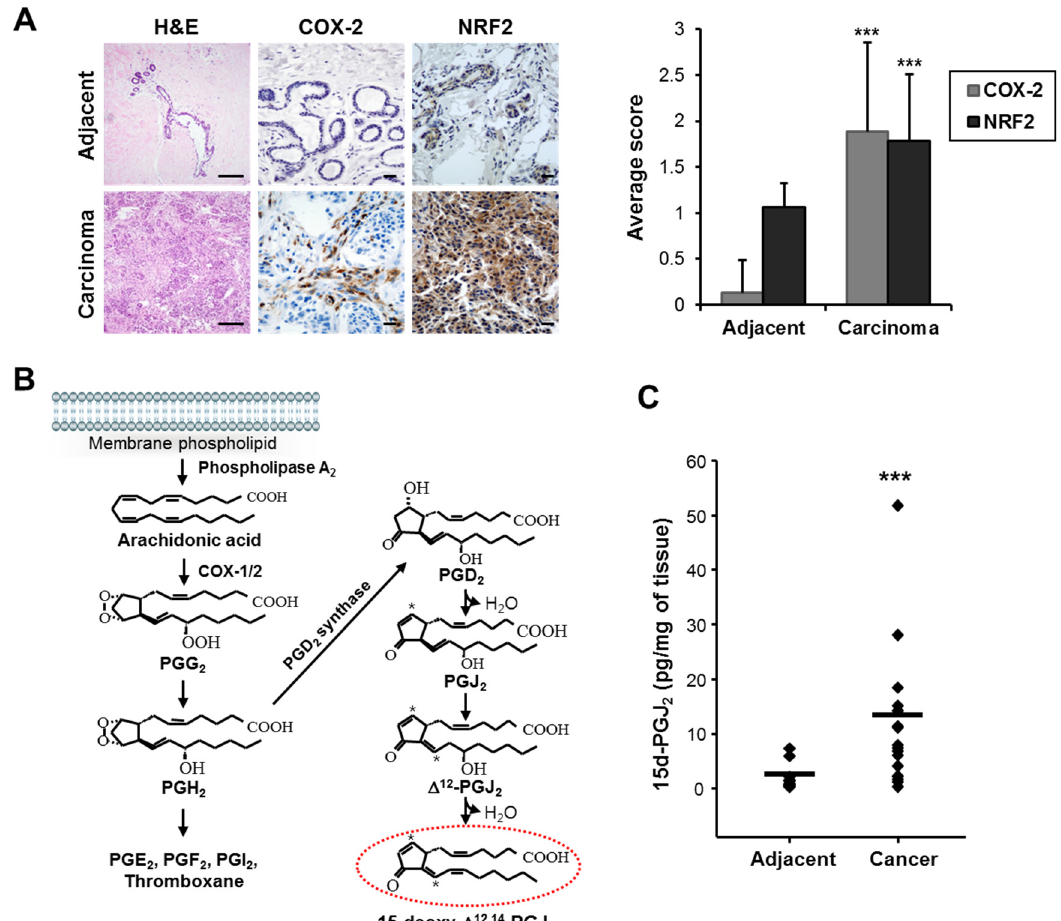
Figure 1. The expression levels of cyclooxygenase-2 (COX-2) and nuclear factor erythroid 2-related factor 2 (NRF2) and 15-deoxy- Δ 12,14 -prostaglandin J 2 (15d-PGJ 2 ) production are increased in human breast cancer tissues. ( A ) The expression of COX-2 and NRF2 in human breast cancer tissues vs. surrounding normal tissues. Paraffin-embedded human breast cancer or adjacent normal tissues were immunostained for COX-2 and NRF2 and counterstained with hematoxylin, as described in the Materials and Methods section. Scale bars indicate 100 µm. ( B ) Formation of 15d-PGJ 2 . Phospholipase A 2 catalyzes hydrolytic release of arachidonic acid (AA) from membrane phospholipids. Cyclooxygenases catalyze oxidative conversion of arachidonic acid (AA) to PGH 2 . PGD 2 , a precursor of 15d-PGJ 2 , is formed by the action of PGD 2 synthase. Alterna- tively, other prostaglandins (e.g., PGE 2 , PGF 2 α , and PGI 2 ) and thromboxanes are formed. PGD 2 undergoes chemical dehy- dration to form the PGJ 2 . PGJ 2 is then subjected to further dehydration by loss of the 15-hydroxyl group, which, coupled with migration of the 13,14-double bond of PGJ 2 , results in the formation of 15d-PGJ 2 . Asterisks indicate the positions of the chemically reactive electrophilic carbon center. ( C ) The elevated levels of 15d-PGJ 2 in human breast cancer tissues. 15d-